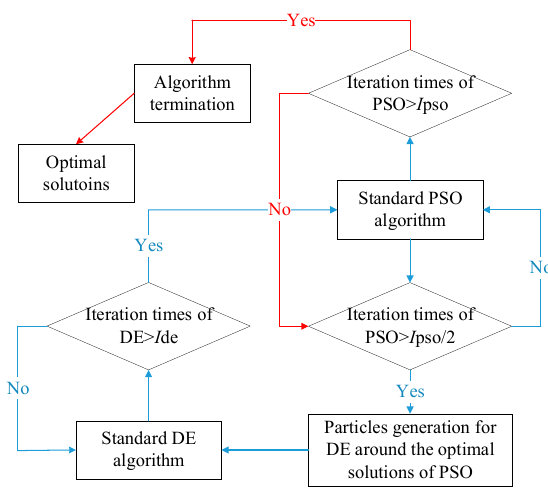
Figure 4. Diagram of hybrid PSO-DE algorithm.